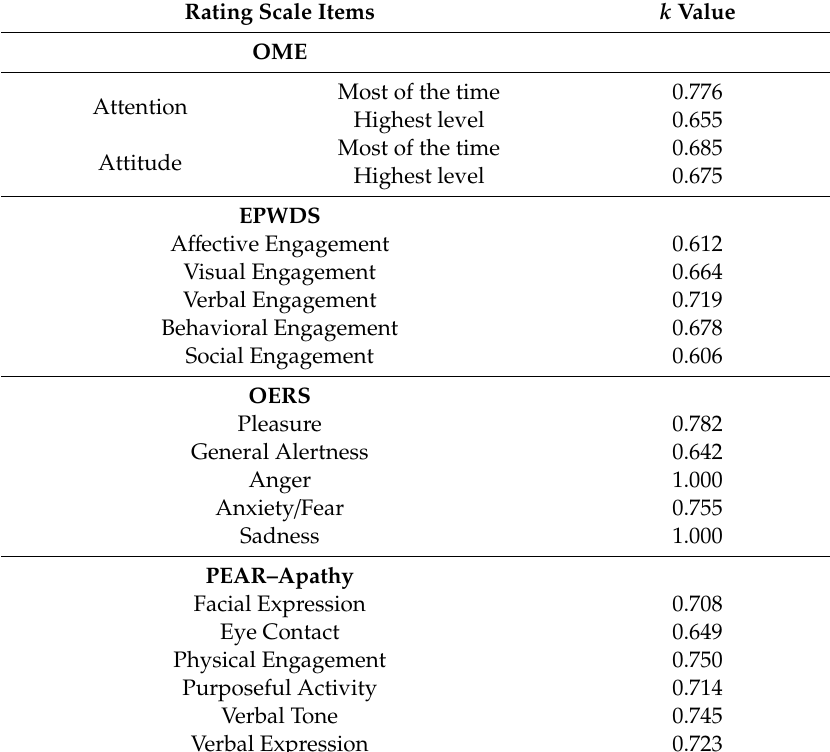
Table A1. Reported Cohen’s Kappa coe ffi cient ( k ) to measure inter–rater reliability between two raters of all rating items of four observational rating